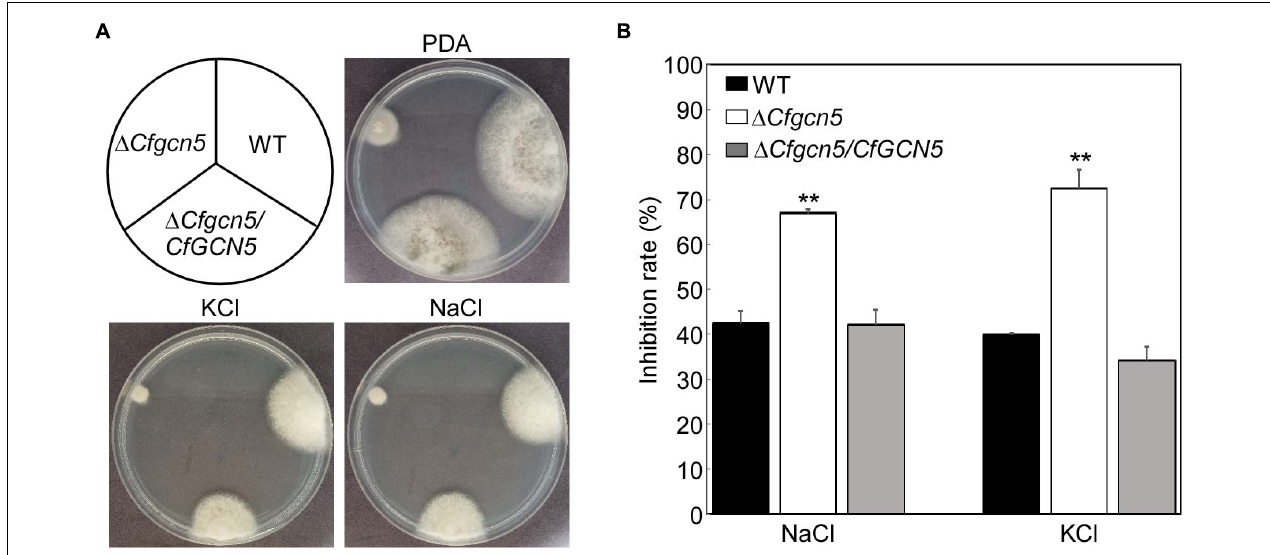
FIGURE 5 | CfGcn5 contributes to the osmotic stresses tolerance. (A) The WT, (cid:49) Cfgcn5, and (cid:49) Cfgcn5 / CfGCN5 were incubated on PDA plates with various osmotic stresses of NaCl and KCl at 28 ◦ C for 4 days. (B) Statistical analysis of inhibition rates of the strains to osmotic stresses against untreated control. Error bars represent SD of three replicates and asterisks indicate significant differences ( p < 0.01).